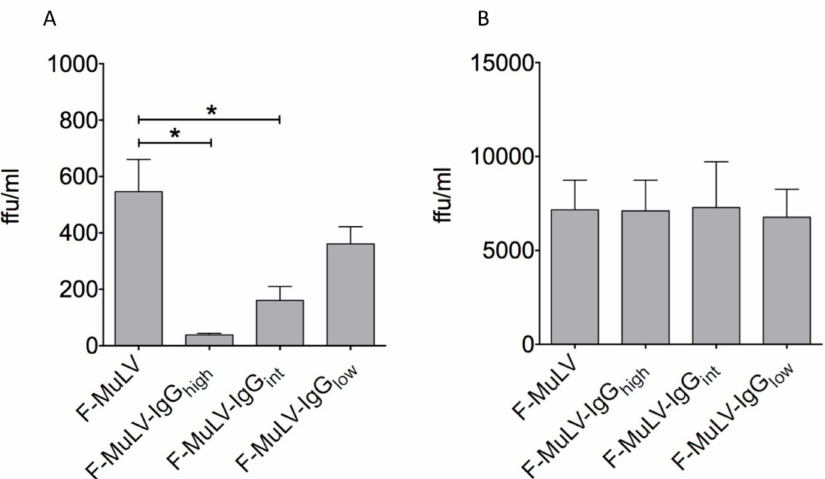
Figure 2. IgG-opsonization diminishes F-MuLV infection of DCs. F-MuLV stocks were opsonized in the presence of 5 µ g/mL (F-MuLV-IgGhigh), 0.5 µ g/mL (F-MuLV-IgGint), or 0.05 µ g/mL